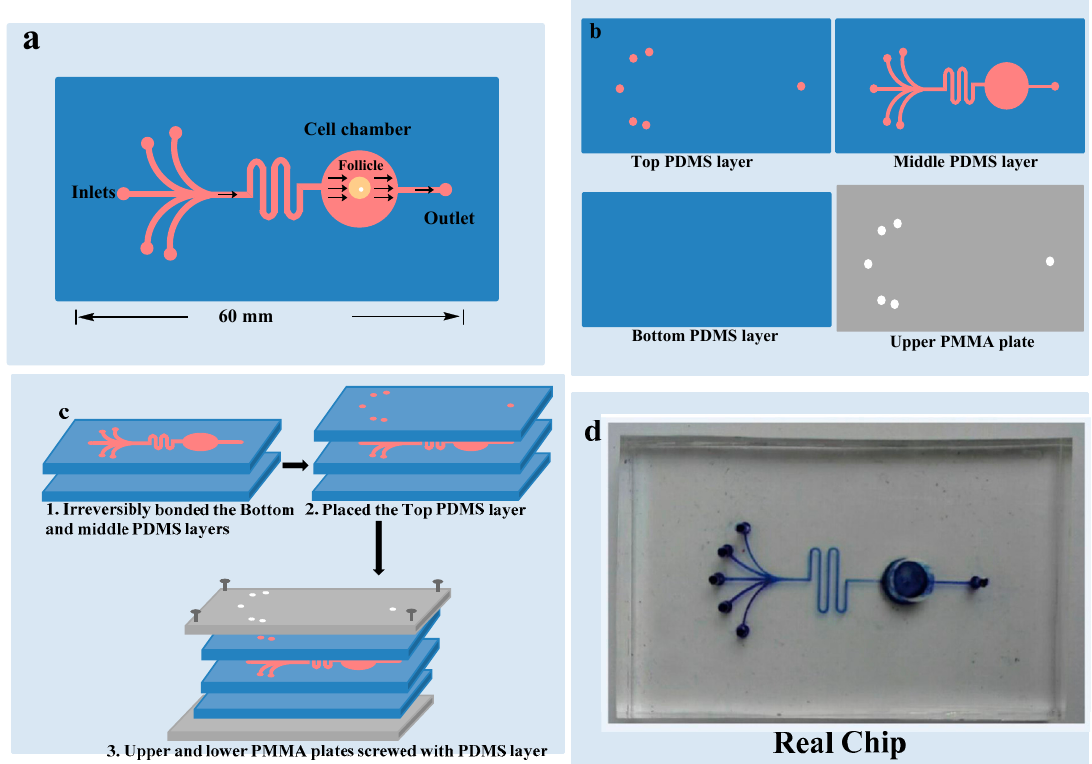
Figure 2. Chip design: ( a ) 5 inlets and 1 outlet with one chamber where OF is cultured; ( b ) 3 polydimethylsiloxane layers and upper polymethyl methacrylate layer; ( c ) All the layers combined together; ( d ) Real chip.